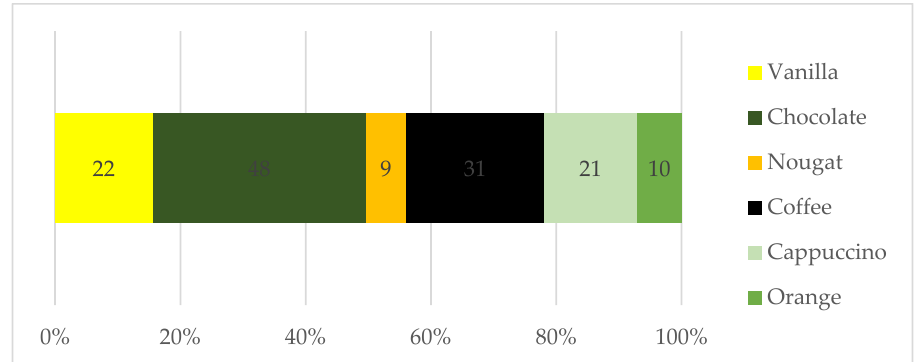
Figure 4. Selection of aromas for the confectionary department.